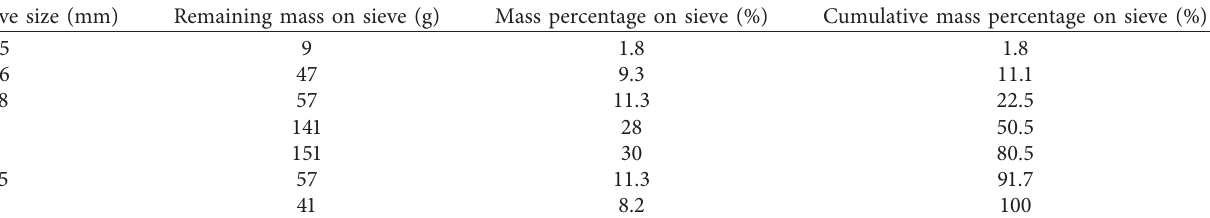
Table 4: Gradation range of fine aggregate.